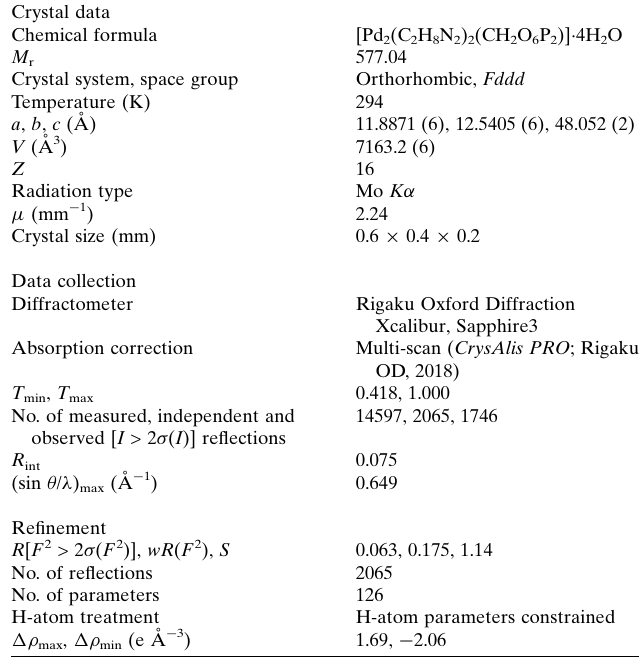
Table 3 Experimental details. Crystal data Chemical